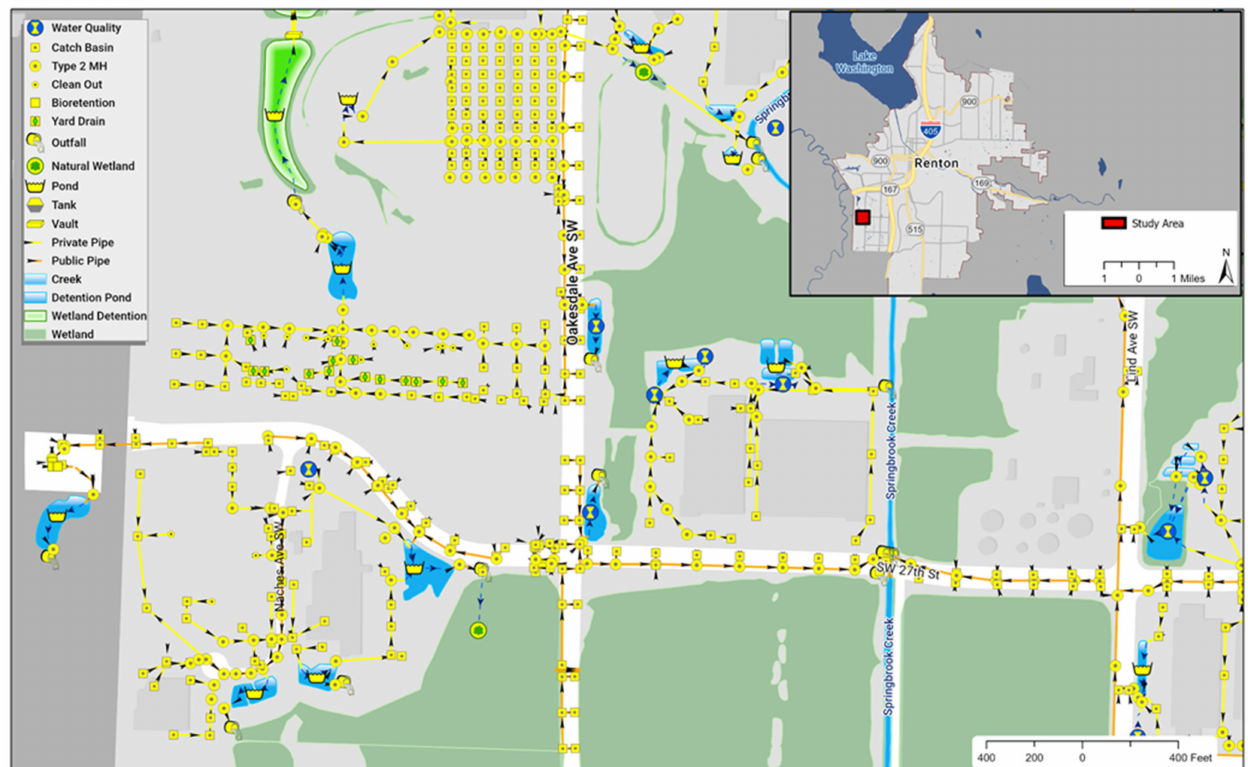
Figure 2. Parts of the stormwater network and existing LIDs in the study